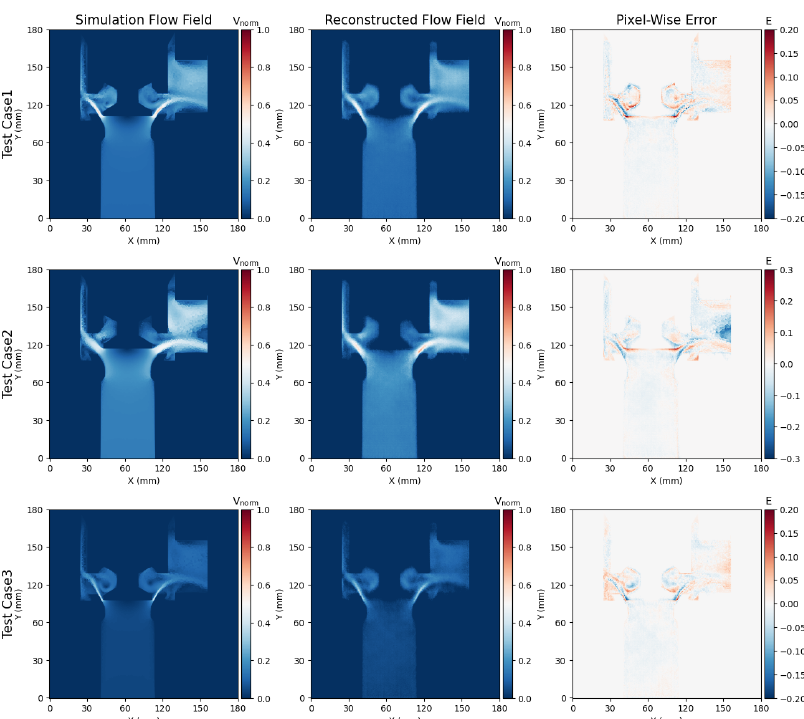
Figure 11. Velocity field reconstruction in training set.